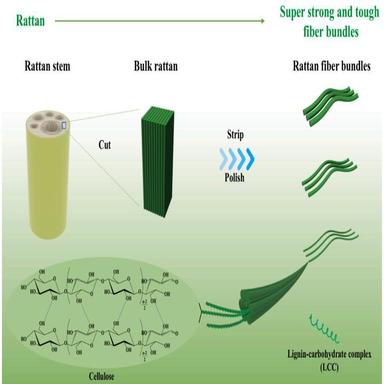
Extraction steps of the rattan fiber bundles: from the rattan stem to fiber bundles of different diameters.